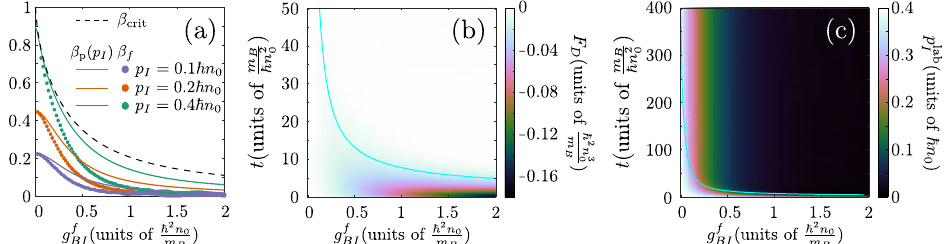
Figure 5. Characterization of the drag force exerted on the impurity by the Bose gas. ( a ) The critical, β crit (dashed line) and equilibrium, β p ( p I ) (solid lines) velocities of the Bose polaron with g BI = g f , BI compared to the final velocity of the polaron formed after the quench, β f ( p I ) (data points) for varying g f . The parameters of the system are as in Figure 4 and p I is given in the legend. ( b ) Temporal BI evolution of the drag force exerted to an impurity, initially possessing p I = 0.4¯ hn 0 , for different values of the post-quench interspecies interaction strength, g f . ( c ) Time-evolution of the impurity BI momentum for p I = 0.4¯ hn 0 and varying g f . The solid lines in ( b , c ) indicate the time that p lab I BI becomes equal to the corresponding value for the equilibrium polaron with g BI = g f BI